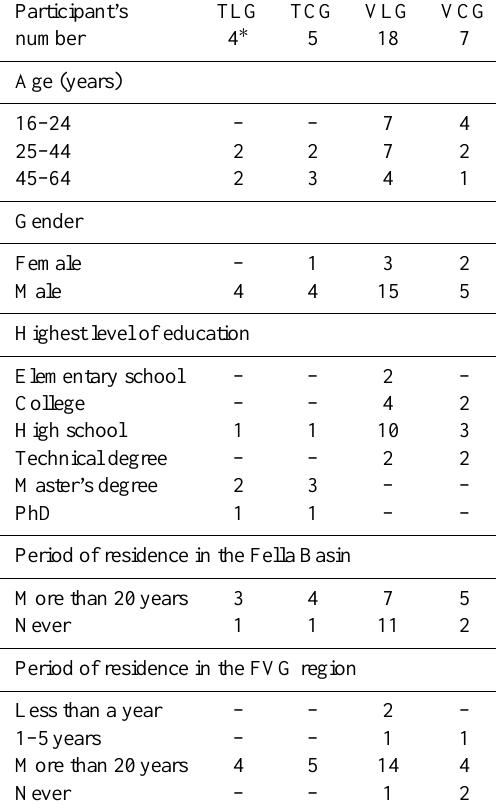
Table A1. Participants’ characteristics for Vs and Ts of learning groups (LGs) and control groups